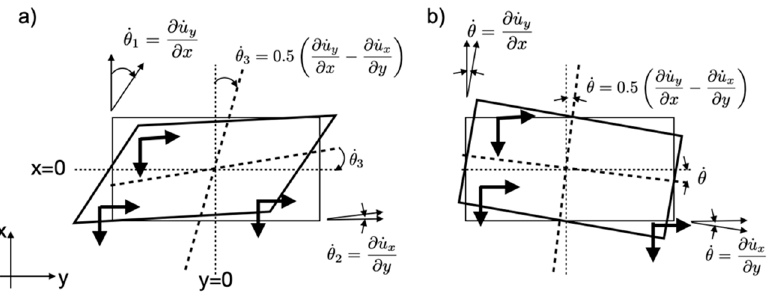
Figure 3. Schematic view of the rotations calculated by the array ( a ) in the case of shear defor- mation and ( b ) in rigid body conditions.